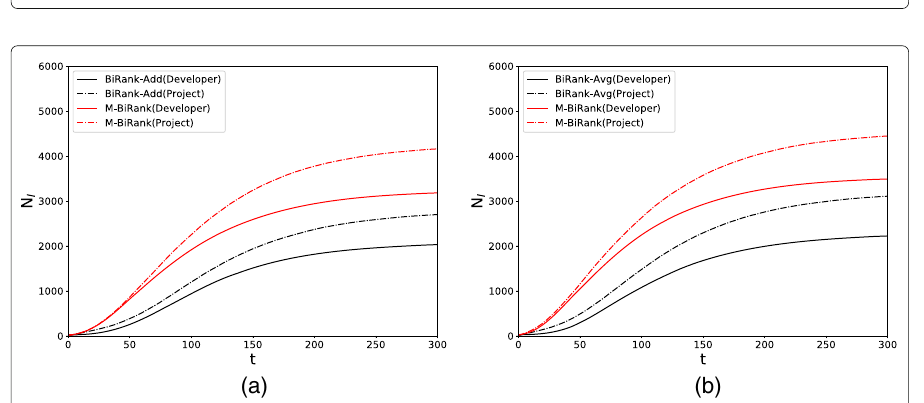
Fig. 6 Performance comparison between M-BiRank and BiRank. The horizontal axis t indicates the number of iterations in SIR modeling. The vertical axis N I indicates the number of final infected nodes (developers or projects, including infected and removed